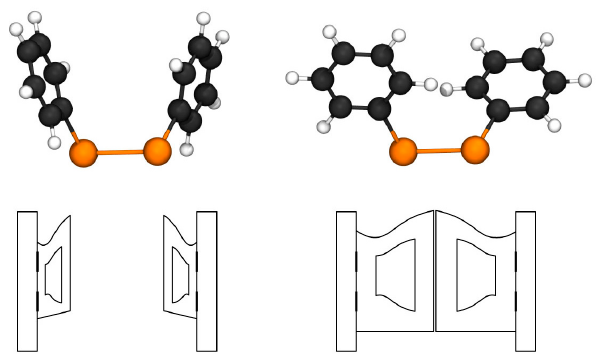
Figure 1. Fully optimized conformers of Ph 2 Te 2 , namely open ( left ) and closed ( right ); the corresponding open and closed doors are sketched below. Level of theory: ZORA-OPBE/TZ2P.